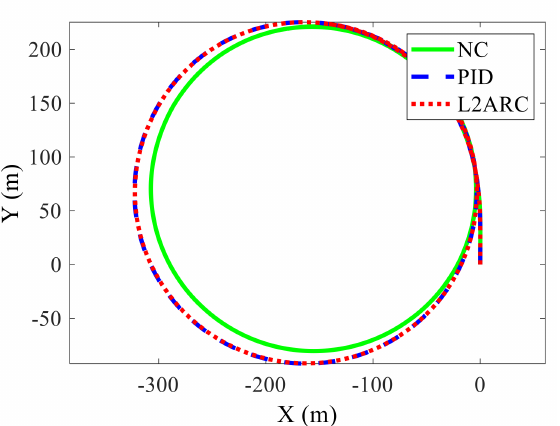
Figure 6. Trajectory of L2-gain adaptive robust control under wave